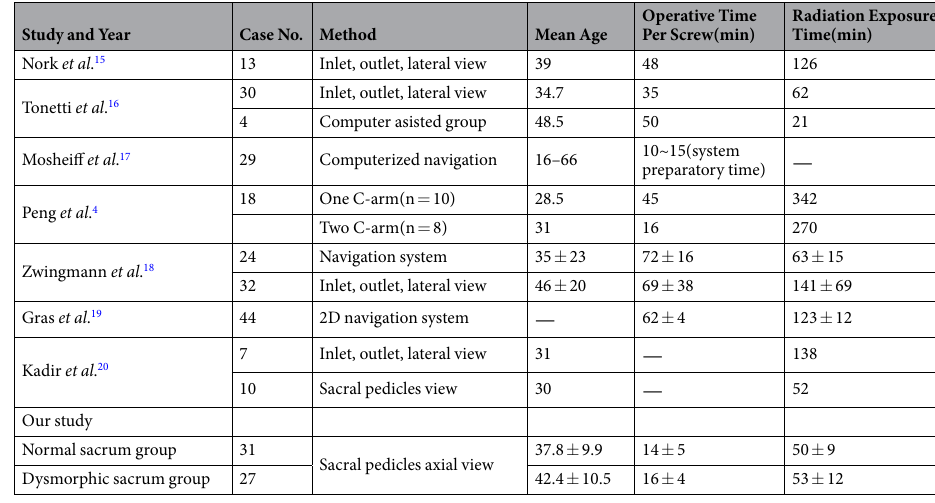
Table 2. Previous reports regarding operative time per screw and radiation exposure